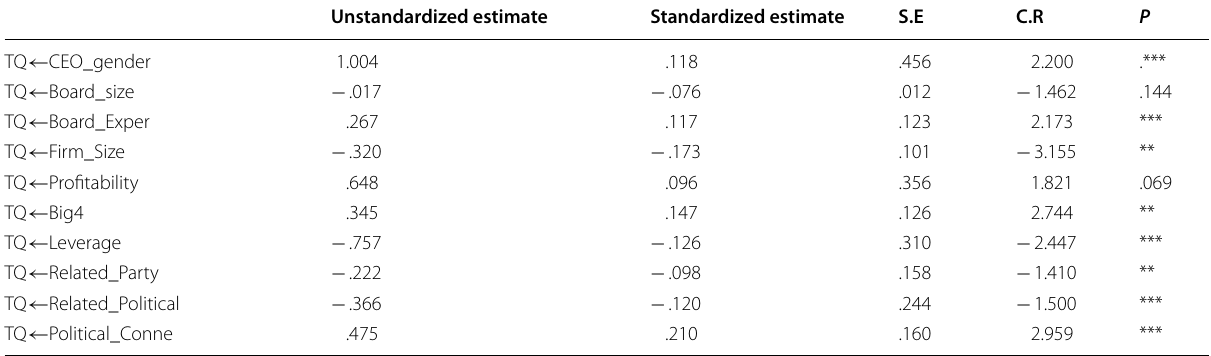
Table 7 Regression weights of SEM (political connections and firm value using the related party transactions as a moderating variable)